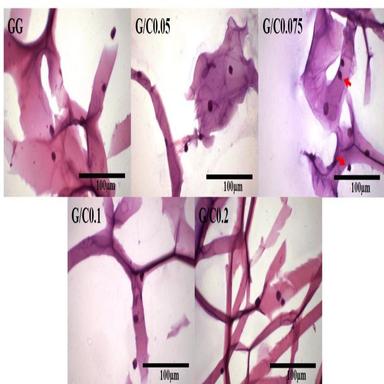
Histological images of (A) H&E and (B) Safranin-O.